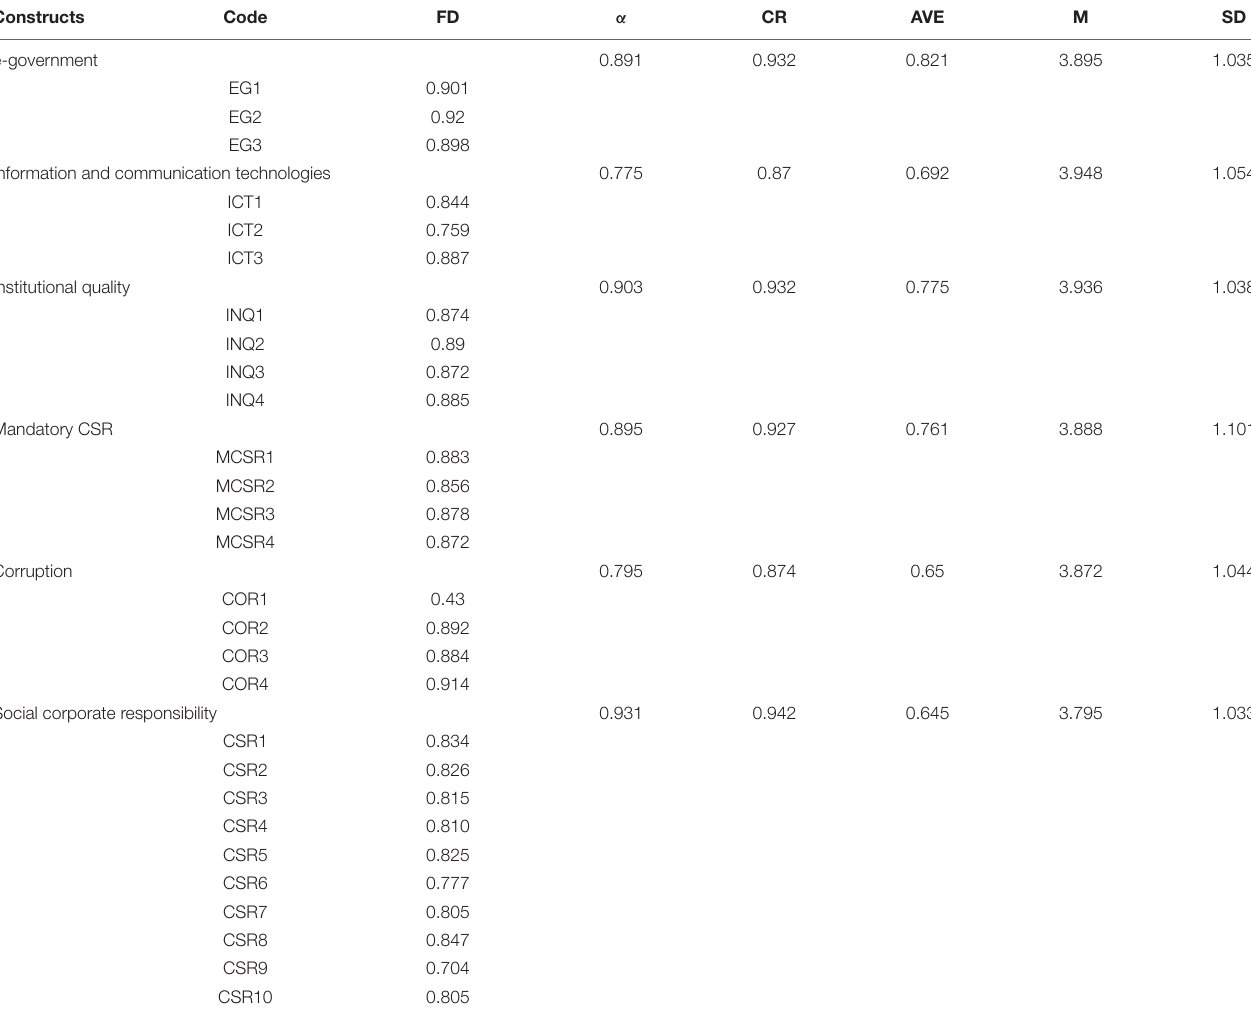
TABLE 2 | Measurement model and descriptive statistics.